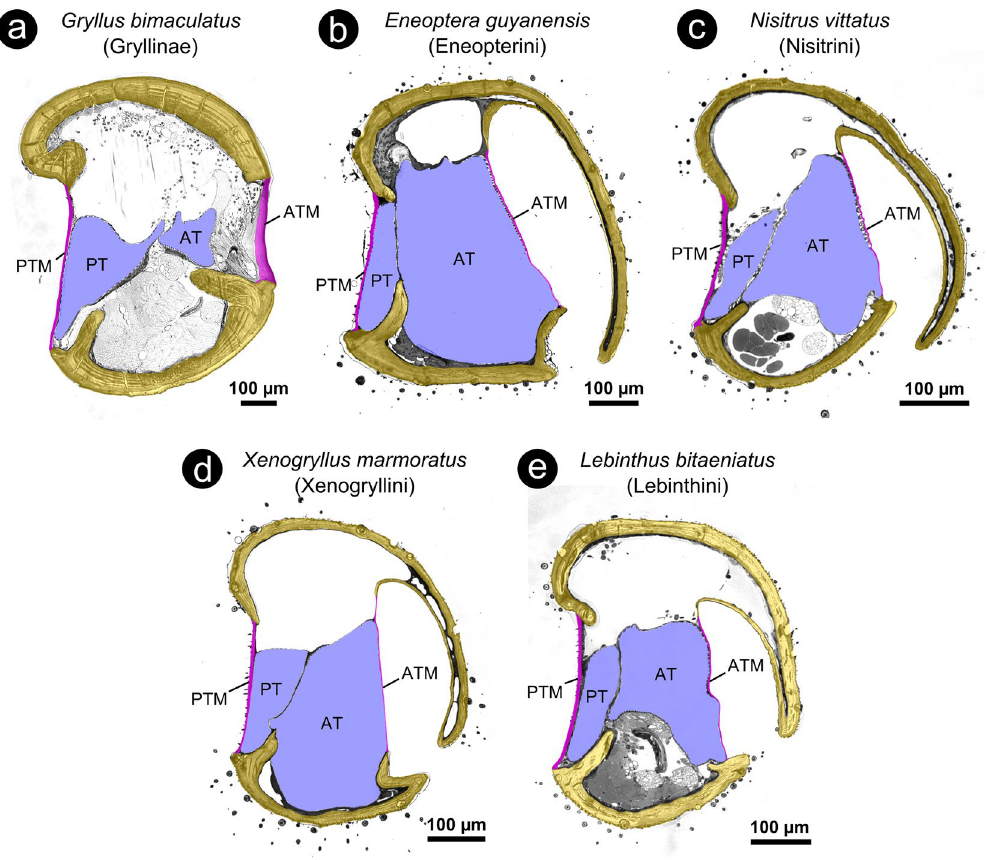
Figure 3. Coloured LM-micrographs of semi-thin cross-sections through the proximal tibia of ( a ) G . bimaculatus (Gryllinae) and of several cricket species of different tribes of the subfamily Eneopterinae ( b – e ). ( b ) E . guyanensis (tribe Eneopterini); ( c ) N . vittatus (tribe Nisitrini); ( d ) X . marmoratus (tribe Xenogryllini); ( e ) L . bitaeniatus (tribe Lebinthini). Note that for E . guyanensis ( b ) and X . marmoratus ( d ) only ethanol-fixed and air dried material was available, respectively. Tissue preservation in these species, therefore, was very poor. Thus, absolute and relative proportions of the internal compartments of the ears shown in ( b ) and ( d ) may not reflect the situation in the living animals (see e.g. the strongly shrunken muscle channel). Colour code: yellow = cuticular portion of the tibia; magenta = cuticular portion of the tympanal membranes; blue = interior of tracheal branches. Orientation: top = lateral; bottom = medial; left = posterior; right = anterior. Abbreviations: AT = anterior tracheal branch; ATM = anterior tympanal membrane; PT = posterior tracheal branch; PTM = posterior tympanal